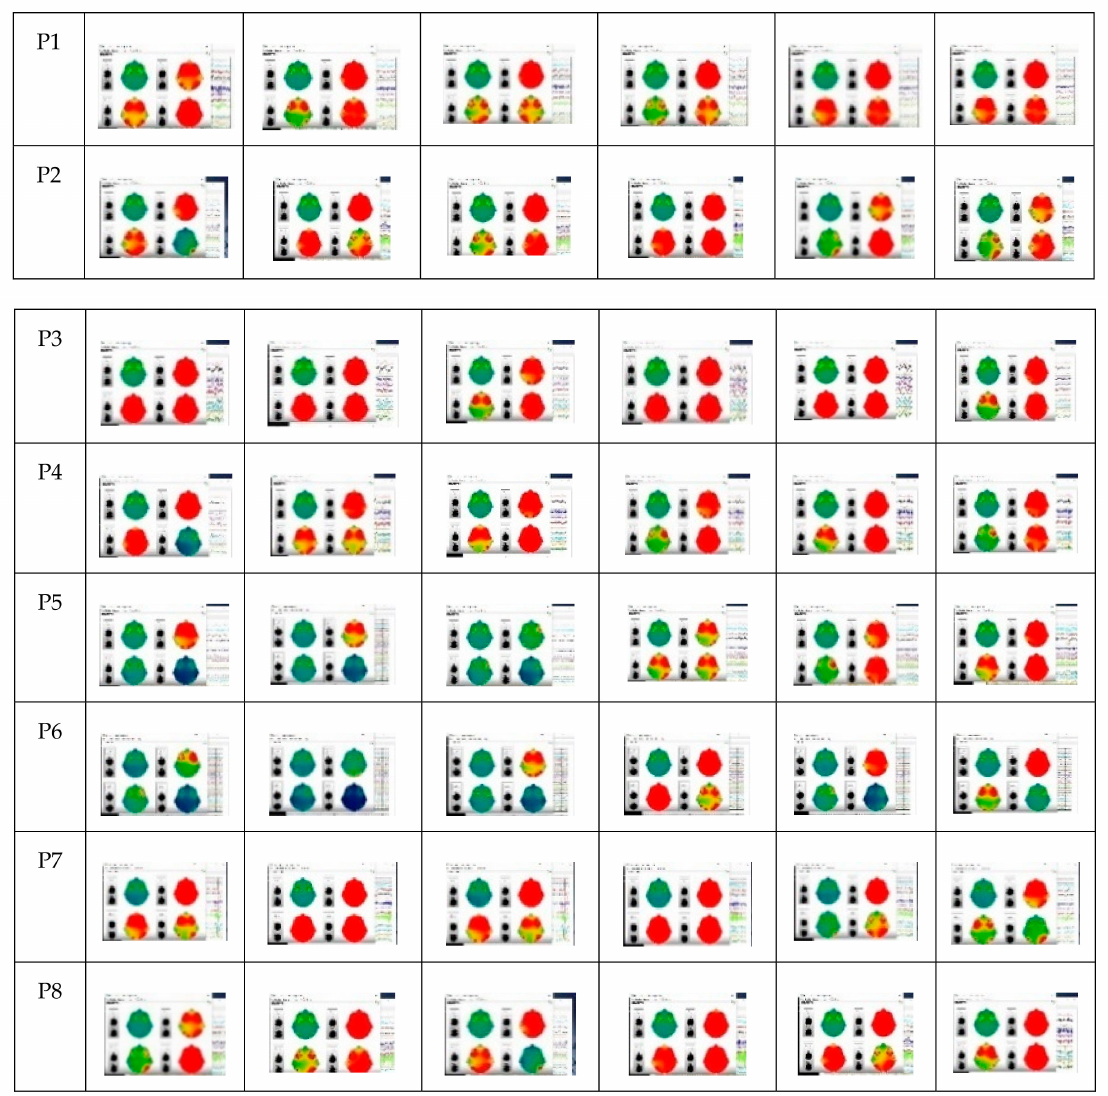
Figure 6. Brain activity sequences of eight participants (one line for each participant) in the “goal” throwing condition. Each frame shows the delta (upper-left), theta (upper-right), alpha (bottom-left), and beta (bottom-right) oscillations of each moment. These frames, taken every two seconds, correspond to the central 12” of the